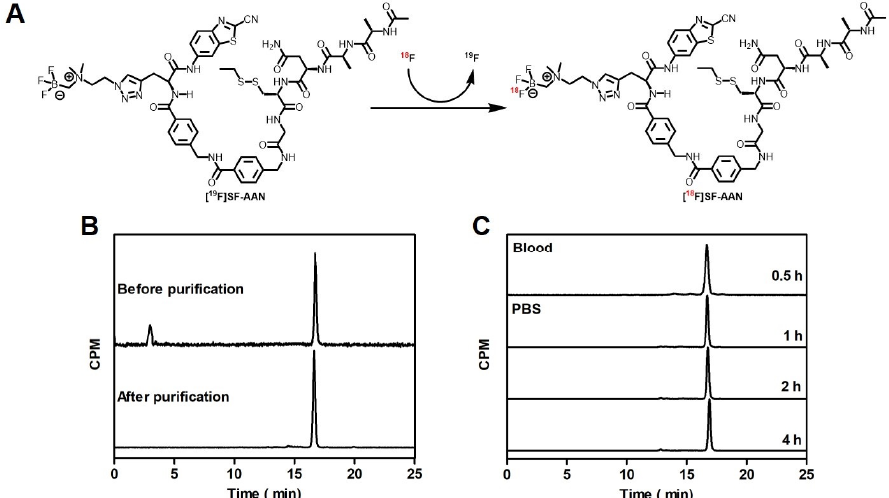
Figure 1. Radiosynthesis and quality control of probe [ 18 F] SF-AAN . ( A ) Radiosynthetic route of probe [ 18 F] SF-AAN . [ 19 F] SF-AAN (25 mM, 20 µ L) was incubated in pyridazine-HCl buffer (350 µ L) at 80 ◦ C for 30 min. ( B ) HPLC characterization of [ 18 F] SF-AAN before and after purification. ( C ) Stability assay of tracer [ 18 F] SF-AAN in PBS at 37 ◦ C (1, 2 and 4 h) and venous blood of nude mice at 30 min post